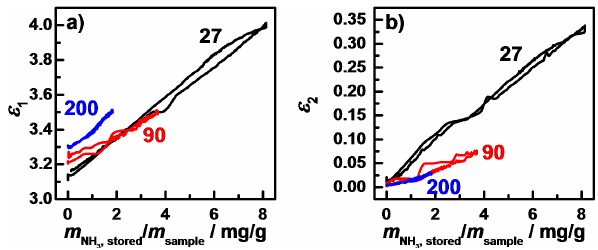
Figure 4. Measurement for an H-ZSM-5 zeolite with Si / Al ratios of 27 (black), 90 (red) and 200 (blue) at 250 ◦ C: (a) ε 1 and (b) ε 2 as a function of the stored amount of ammonia in the